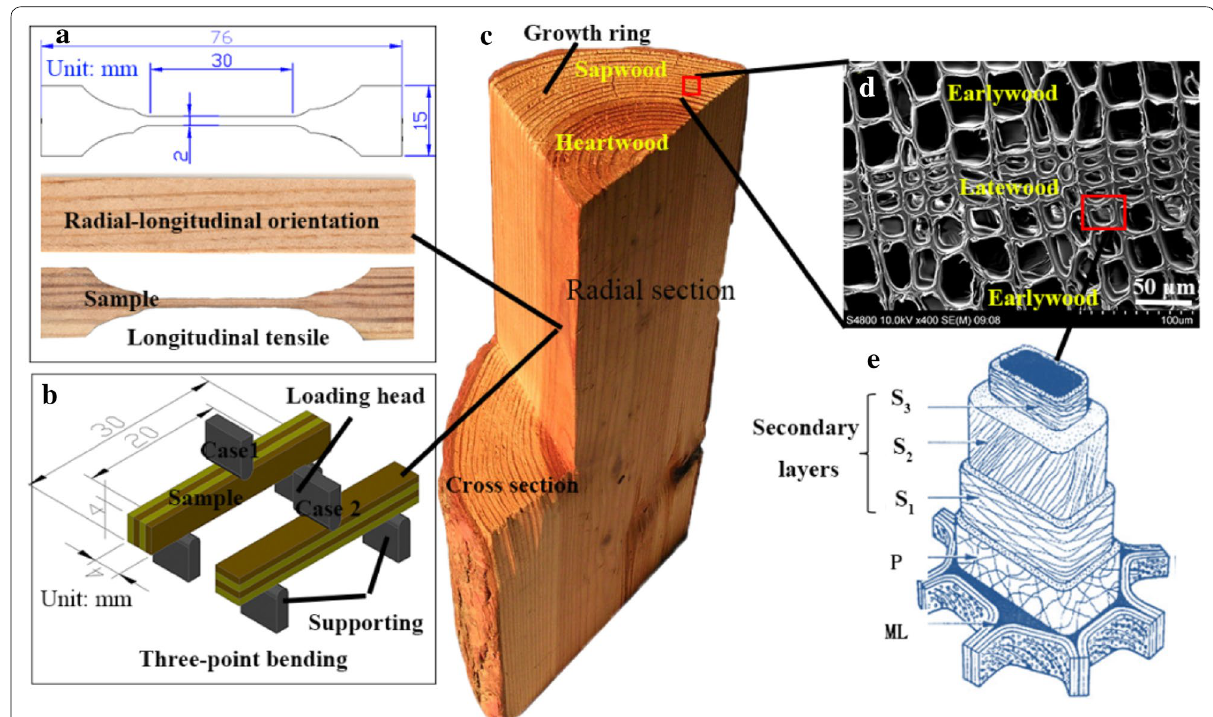
Fig. 1 Preparation of tensile and bending samples and wood multiscale structures. a Longitudinal tensile; b three-point bending; c solid wood; d honeycomb structure; e cell wall concentric laminated